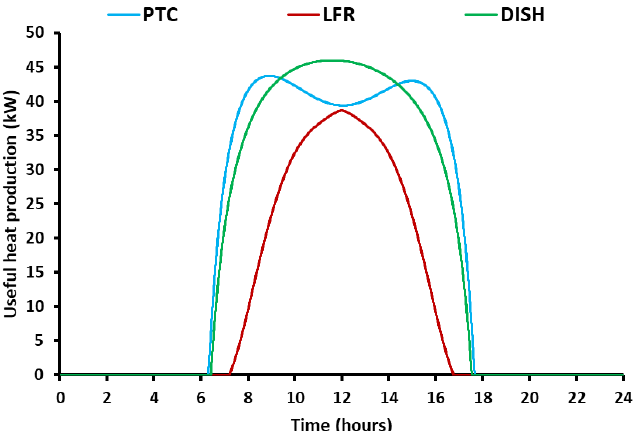
Figure 6. Daily variation of the useful heat production for the three collectors in June. Figure 5. Daily variation of the available solar irradiation for the three collectors in June.